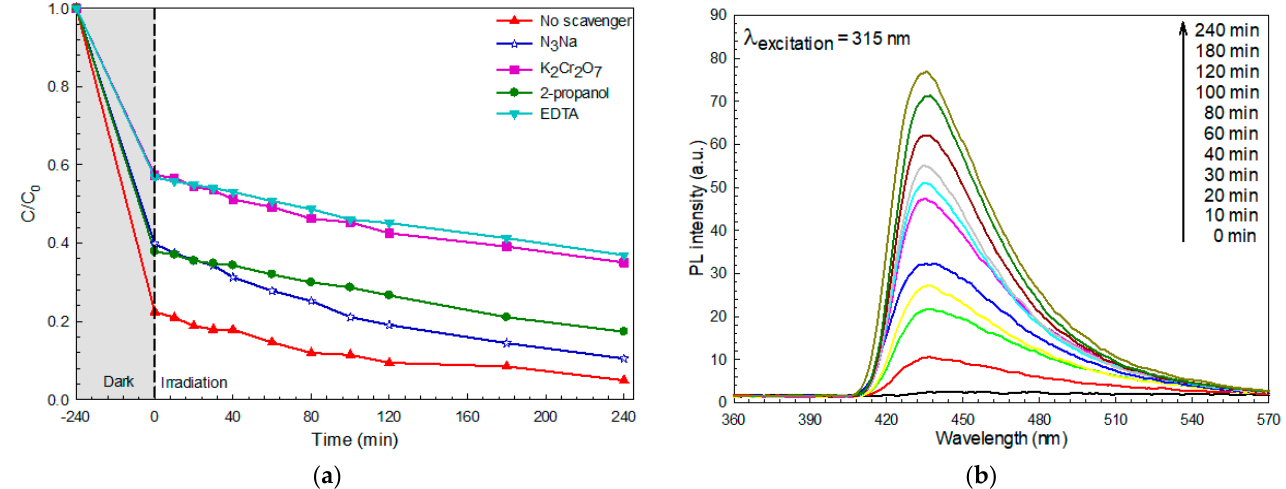
Figure 7. A decrease in C/C 0 with time due to photodegradation of RhB dye after addition of various scavengers ( a ), and hydroxyl radical trapping PL spectra of the prepared BiOI photocatalyst after photo irradiation ( b ).